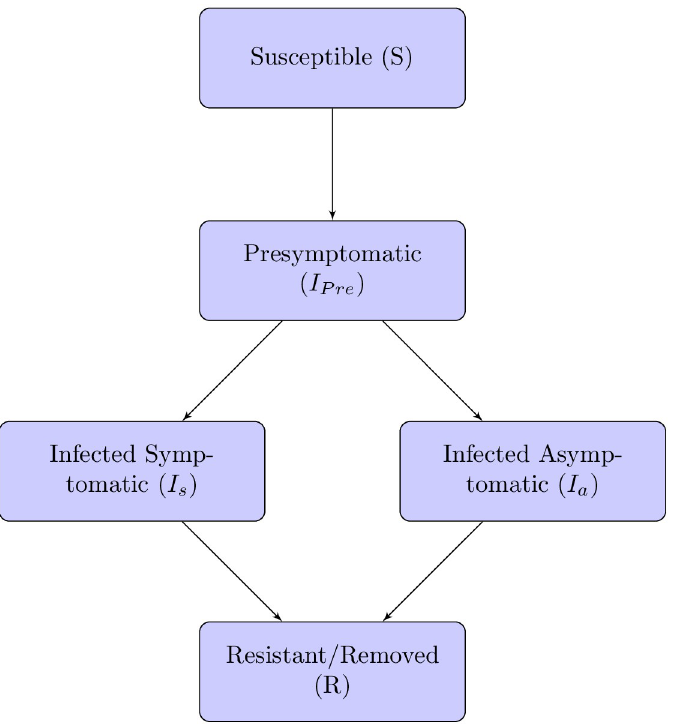
Fig 1. Agent infection states. Flow chart of infection pathways in the agent based